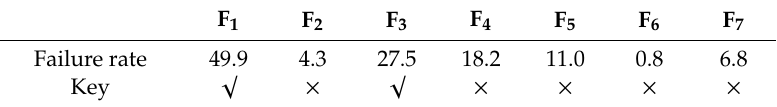
Table 7. Failure rate (10 − 6 /